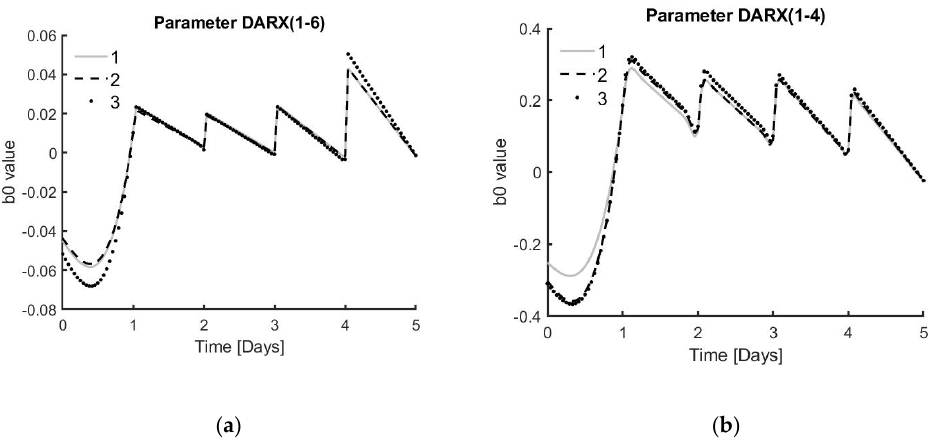
Figure 6. Graphs exhibiting the b 0,t values over time. ( a ) b 0,t values for triplicates of donor 1 under condition 6, which means 100% medium replacement every 24 h. ( b ) b 0,t values for triplicates of donor 1 under condition 4, which means only 10% medium replacement every 24 h.